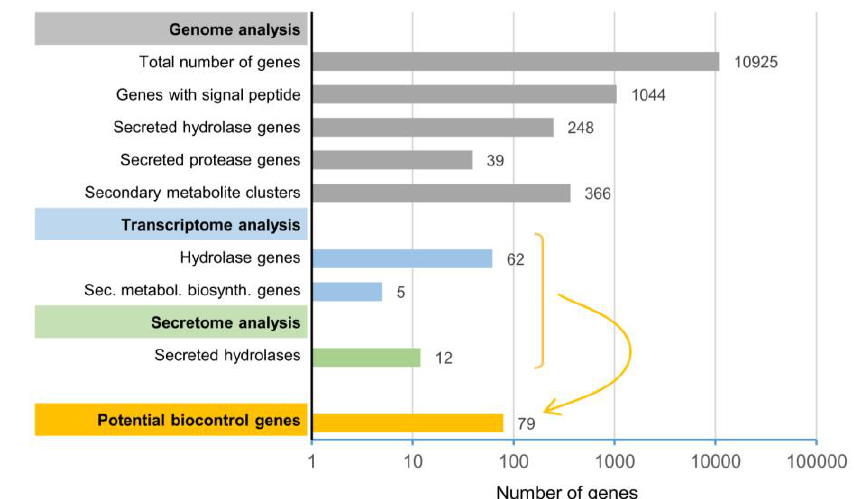
FIGURE 8: Genome, transcriptome, and secretome analyses were used to reduce the number of target bio- control genes for functional analyses from 10,925 (total number of A.